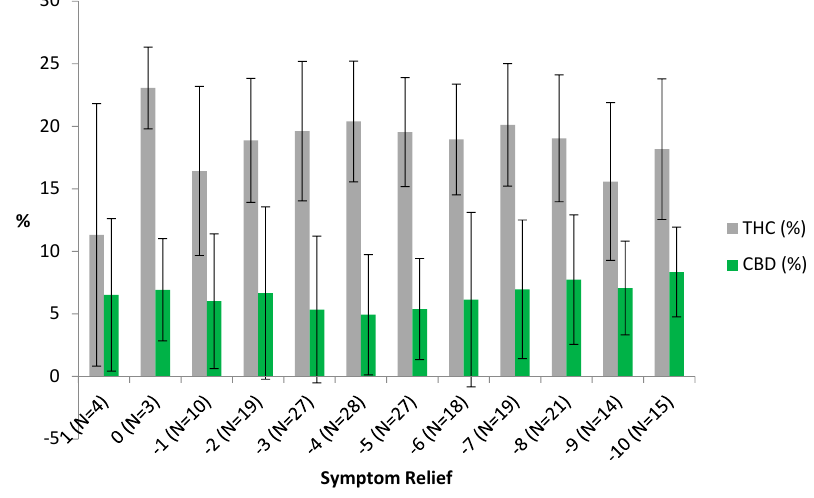
Figure 1. THC and CBD Levels by Symptom Relief Experienced. Symptom relief is measured as ending symptom level minus starting symptom level with − 10 the maximum level of symptom relief. Error bars show the range of values within one standard deviation of the mean. No users who reported THC and CBD percentages reported symptom levels worsening by more than one unit. The number of sessions for each level of symptom relief is reported in parentheses with the sample restricted to those users reporting both CBD and THC potency levels, which range between 0% and 30% and 2% and 35%,